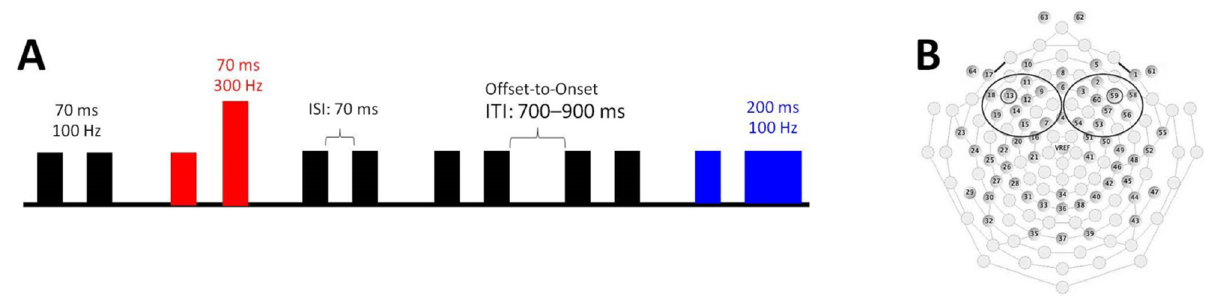
Figure 2. ( A ) Schematic representation of the multi-feature oddball paradigm; ( B ) selected electrode and cluster